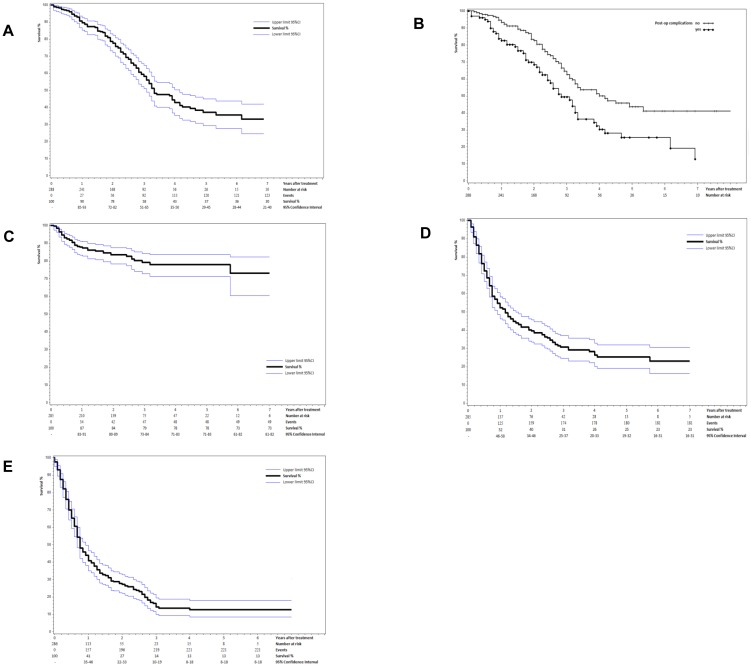
Survival curves and for patients with liver metastases treated by resection combined with intra-operative ablation (IOA).
A Overall survival (OS) and 95% confidence intervals (CI). B OS according to whether complications occurred or not during resection combined with IOA. C Local recurrence-free survival (LRFS) and 95%CI for patients treated by surgery and ablation for colorectal liver metastases (CLM) (N = 285). D Hepatic recurrence-free survival (HRFS) and 95%CI for patients treated by surgery and ablation for CLM (N = 285). E Progression-free survival (PFS) and 95%CI for patients treated by surgery and ablation for CLM (N = 285).